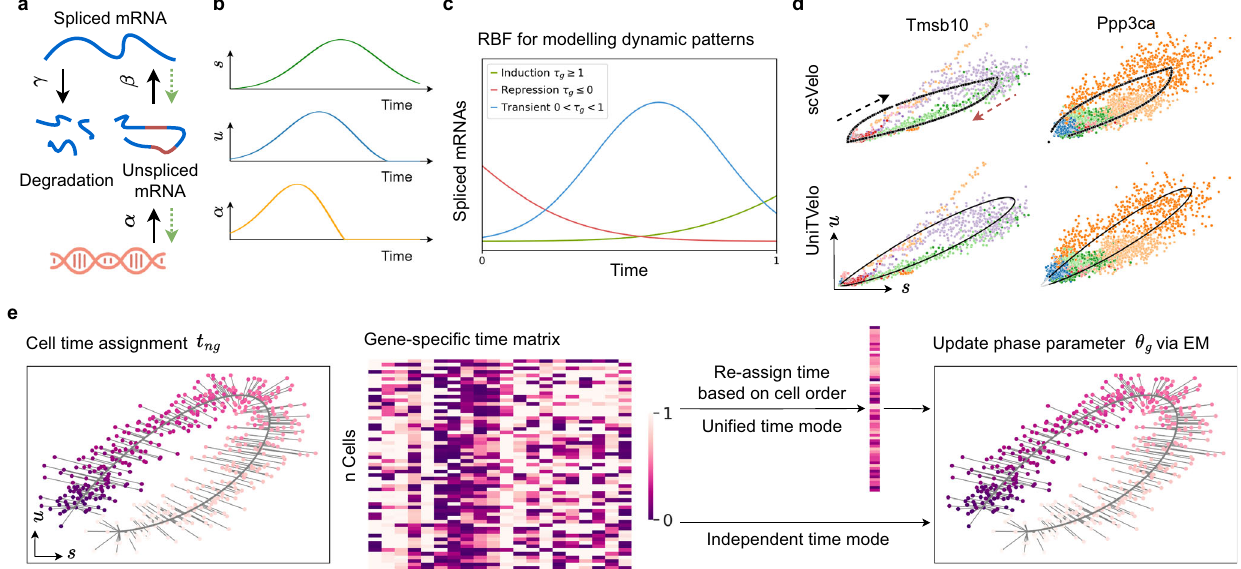
Fig. 1 | Illustration of UniTVelo for modelling of transcription dynamics and RNA velocity.a Illustrationof transcriptionalprocesswhich involvestranscription rate α , splicing rate β , and degradation rate γ . Green dotted line indicates that parameters are inferred reversely. b Paradigm of the model in a with time as independent variable, showing predicted changes of α with regards to measured expression pro fi le. c RBF for modeling patterns of induction, repression, and transient dynamicsof eachgene, where τ g represents the peaktime.Latent time of thismodelisrescaledandtruncatedbetween0and1. d Exampleofphaseportraits (canbesplittedtoinductionandrepressionstagesfromthemiddle,showninblack and red arrows respectively) of two dynamical genes modeled by both scVelo and UniTVelo, Tmsb10 and Ppp3ca , showing RBF kernel has a similar ability to recover